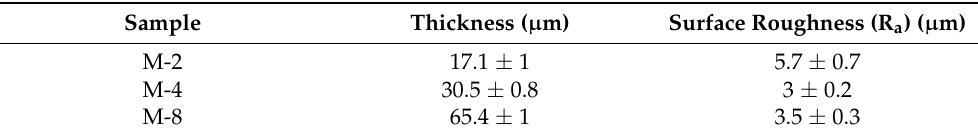
Figure 5. Low-magnification SEM micrographs of M-2 (2 passes), M-4 (4 passes), and M-8 (8 passes) membranes. Table 5. Thickness and surface roughness of M-2, M-4, and M-8 membranes.